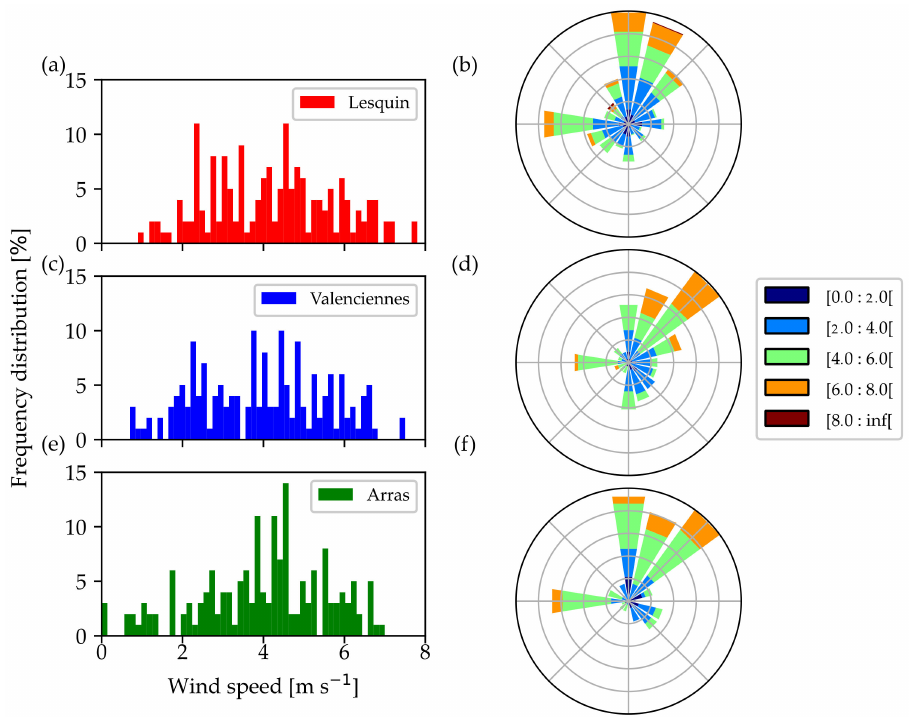
Figure 9. Frequency distribution of wind speed for: ( a ) M é t é o France (Lesquin–50 ◦ 20 (cid:48) 24 (cid:48)(cid:48) N 3 ◦ 04 (cid:48) 12 (cid:48)(cid:48) E), ( c ) M é t é o France weather station at Valenciennes (50 ◦ 21 (cid:48) 36 (cid:48)(cid:48) N 3 ◦ 05 (cid:48) 24 (cid:48)(cid:48) E), and ( e ) M é t é o France weather station at Arras (50 ◦ 15 (cid:48) 36 (cid:48)(cid:48) N 2 ◦ 52 (cid:48) 12 (cid:48)(cid:48) E). Wind direction distribution for: ( b ) M é t é o France weather station at Lesquin, ( d ) M é t é o France weather station at Valenciennes, and ( f ) M é t é o France weather station at Arras. All data were recorded between 24 June 2019 and 30 June